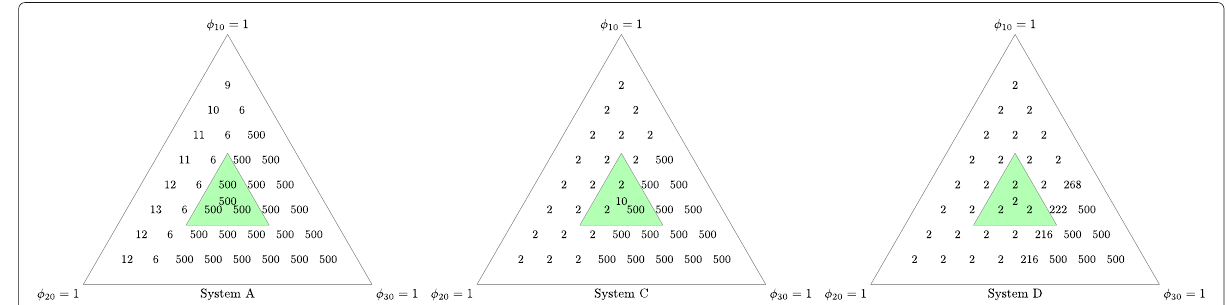
Fig. 2 Barycentric grid with at each grid point the number of consecutive iterations yielding solutions with realistic behavior for Systems A, C and D , respectively. The volume fraction values of that grid point were used as initial conditions. The shaded central triangle indicates the parameter region for which the existence proof in [40] works for a finite time interval